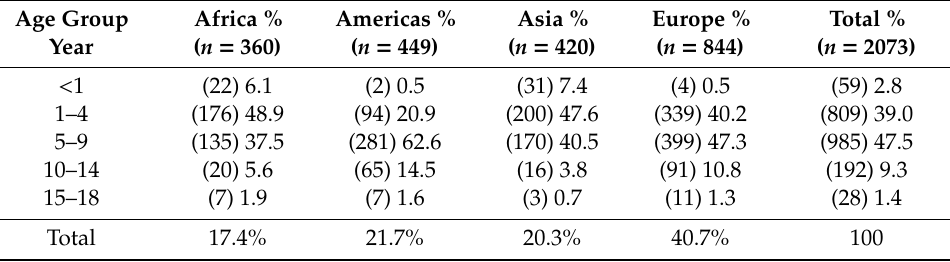
Table 2. The continent of origin of the internationally adopted children (IAC) referred to Meyer Children’s University Hospital, Florence, in the period (2009–2019), by age group (%).